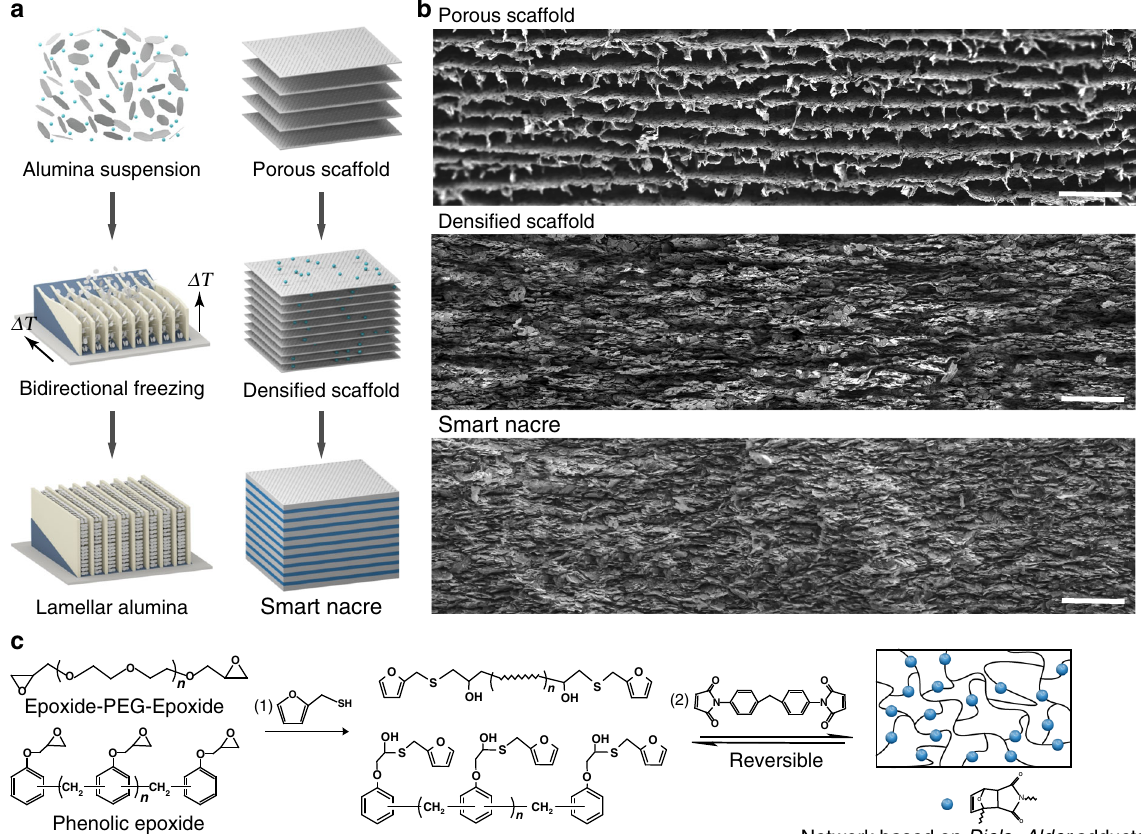
Fig. 1 Fabrication of the smart nacre by in fi ltrating a long-range aligned alumina scaffold with a thermally switchable Diels – Alder network polymer. a Fabrication steps for the smart nacre. b Scanning electron microscope (SEM) images of the porous alumina scaffold, the densi fi ed scaffold, and the smart nacre. c Synthetic route and reversible crosslinking for the Diels – Alder network polymer. Scale bar in b is 100 μ